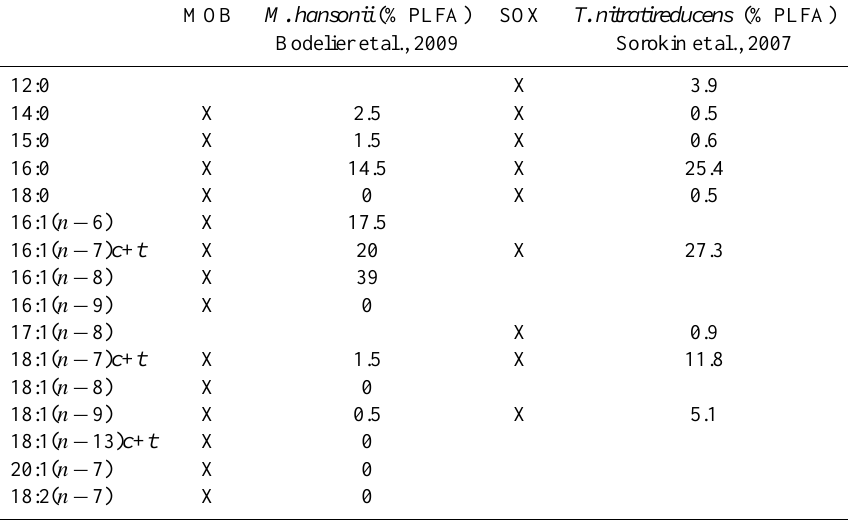
Table 1. PLFA displaying significant enrichement after the tracer experiments with H 2 S+ 13 CO 2 (SOX) or with 13 CH 4 (MOB). X = 13 C labeled. % PLFA = proportion of the PLFA content in cultured strains of Methylosphaera hansonii and Thiohalomonas nitratireducens . MOB M. hansonii (% PLFA) SOX T. nitratireducens (%